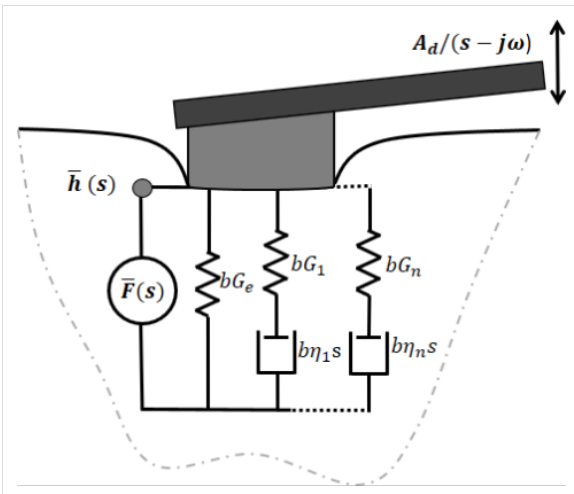
Figure 1: Mechanical model diagram of a flat-end indenter pene- trating into a Generalized Maxwell (Wiechert model) viscoelastic sur- face. The model diagram shows the relationship between the Laplace transformed penetration and the transformed